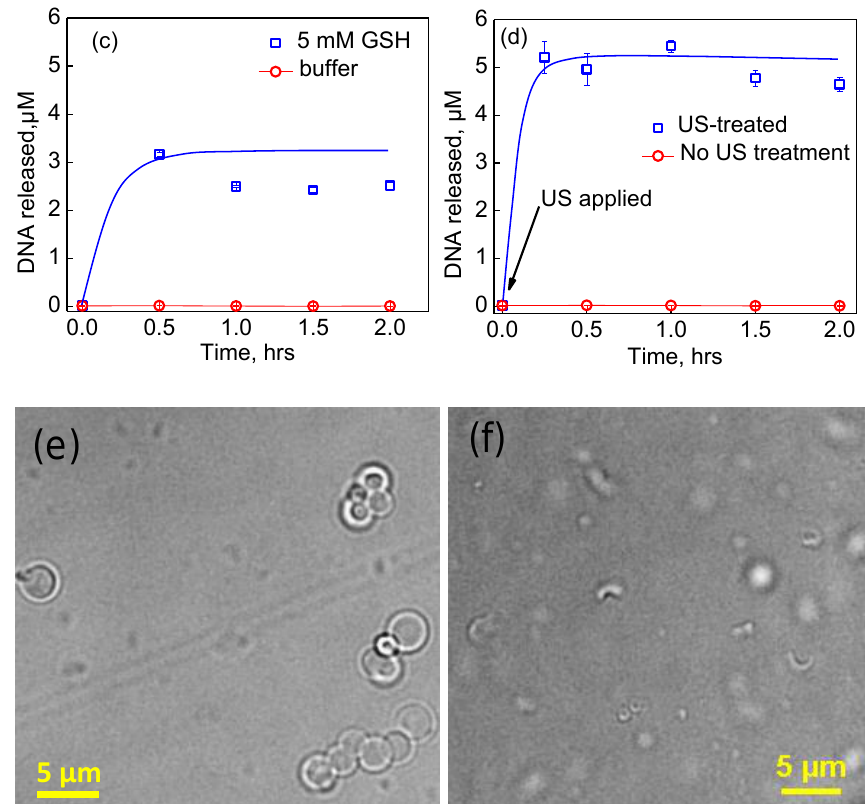
Figure 6. Release of DNA from (PMAA/PVPON) 6 hydrogel capsules via ( a ) GSH-treatment and ( b ) US irradiation. Capsules treated ( c ) with 5 mM GSH at 37 °C and ( d ) with US, were pelleted via centrifugation and the supernatant was removed for quantification via UV – Vis absorbance at 260 nm. For each marker, three aliquots were taken for measurement and averaged. Optical images of (PMAA/PVPON) 6 hydrogel capsules ( e ) before and ( f ) after US irradiation (14 W/cm 2 for 60 s in 20-s bursts).